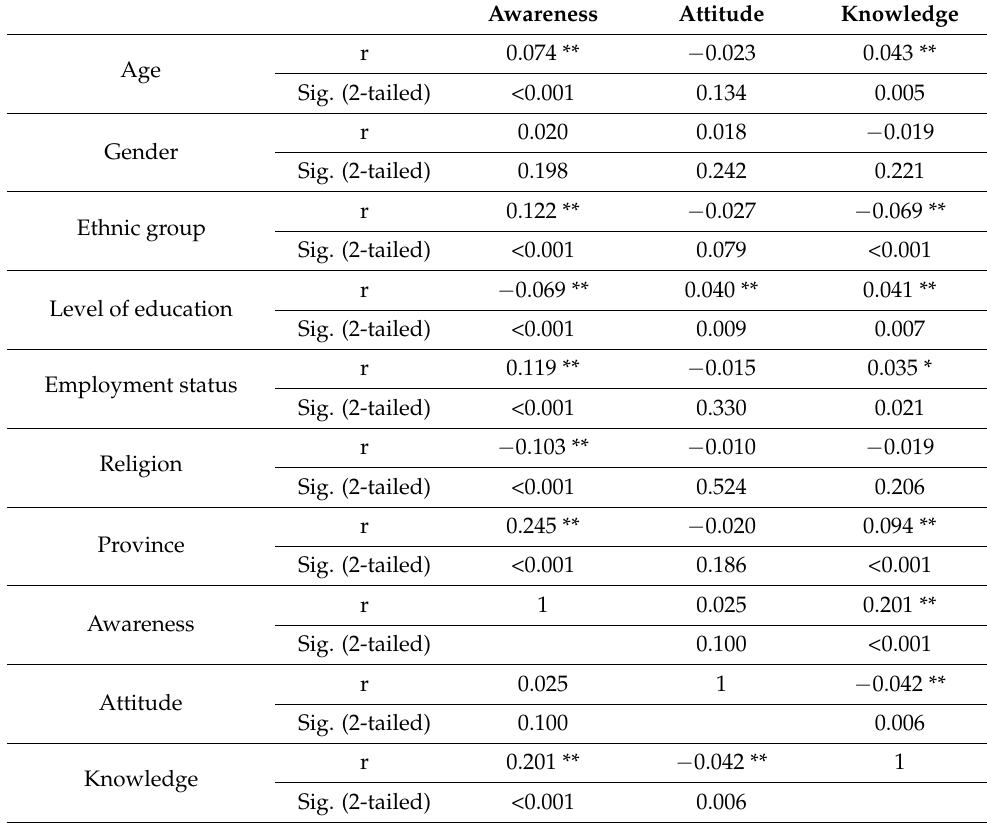
Table 4. Correlations.